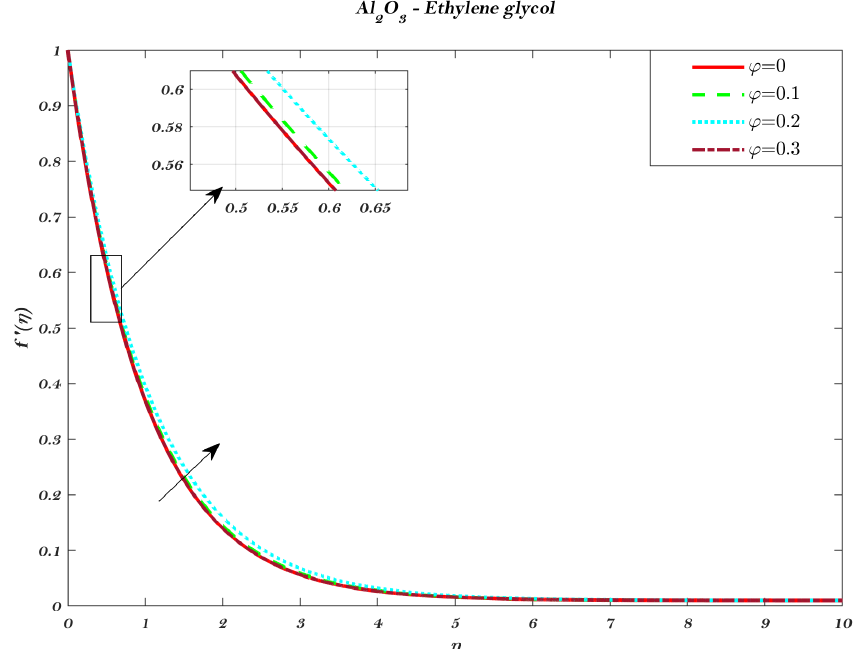
Figure 3. Velocity profile as a function of nanoparticle volume fraction ϕ with fix parameters (cid:101) = 0.02 ˘ a = 0.01 and P r =